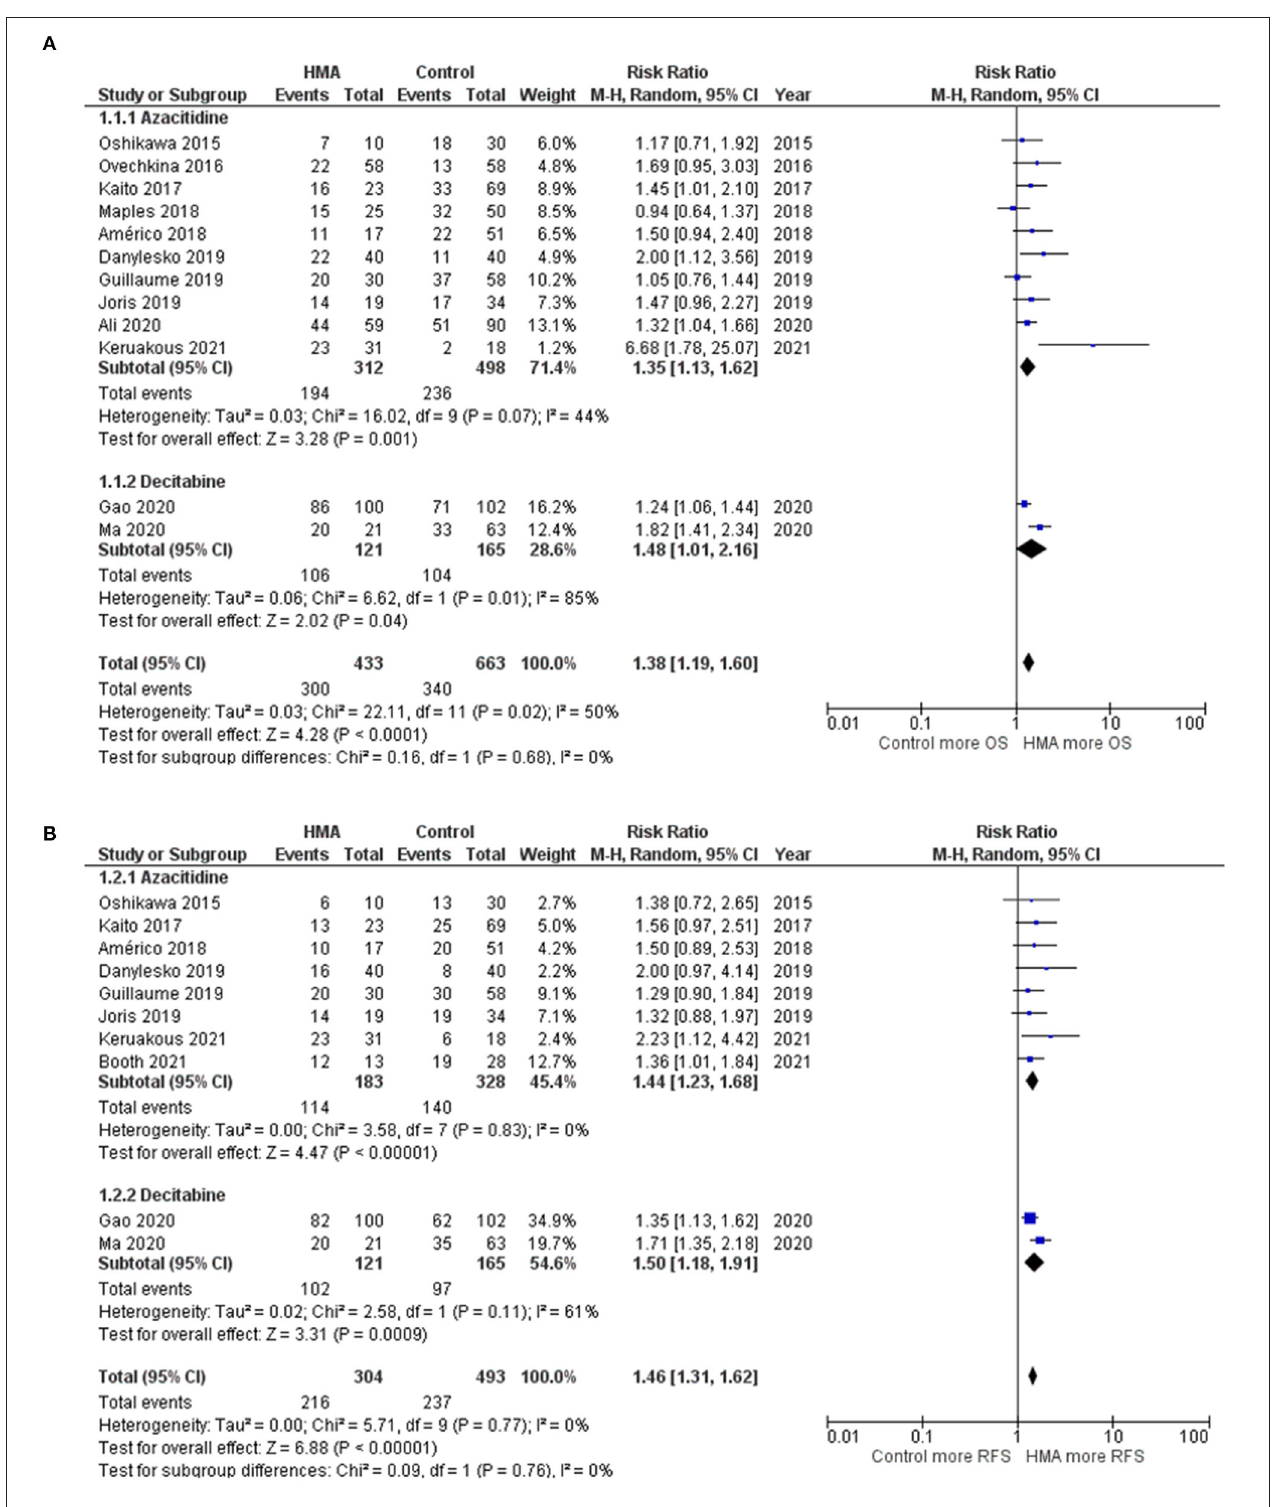
FIGURE 2 | Forest plots of the meta-analysis of HMA maintenance compared with no HMA maintenance. (A) OS rate. (B) RFS rate.